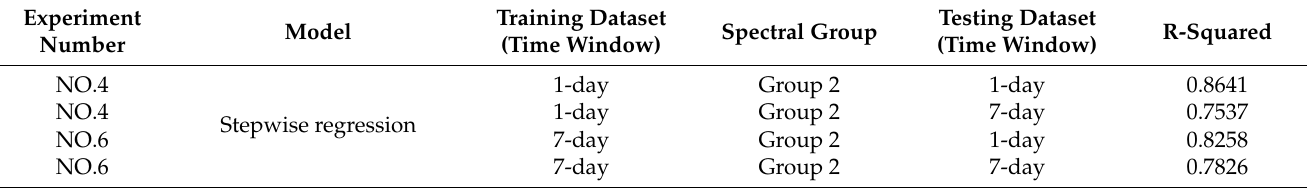
Table 5. Effect of the time window of the training set on the prediction results of the stepwise regression model (with spectral variable group 2 as an example). Group 2 represents the spectral variables that used a band combination and band ratio arrangement. The experiment number corresponds to Table 3.